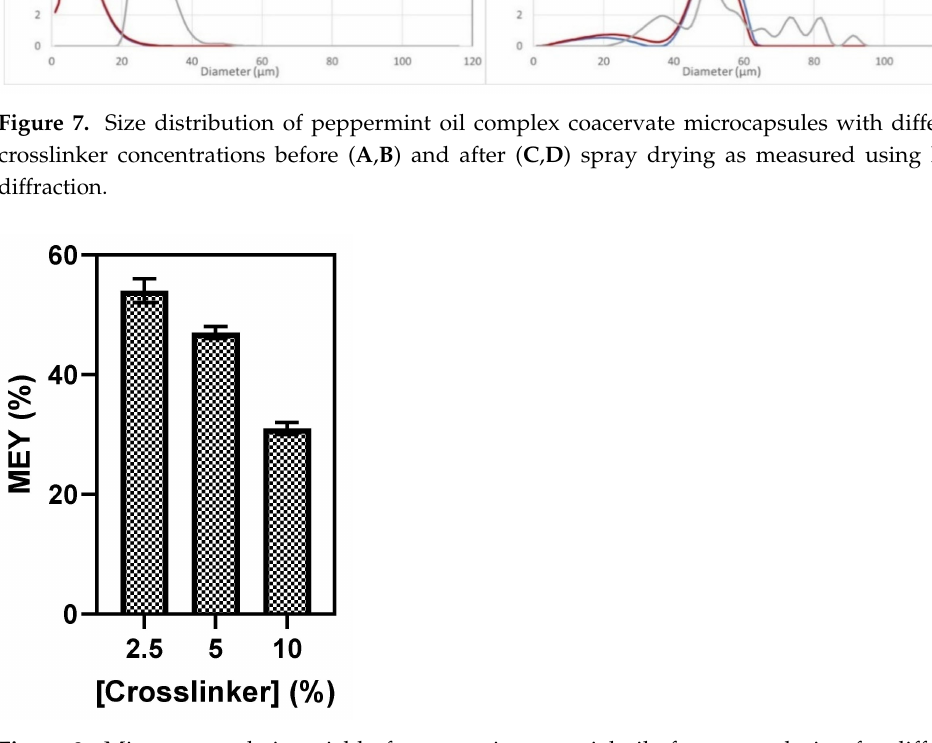
Figure 8. Microencapsulation yield of peppermint essential oil after spray drying for different crosslinker concentrations. Here, Polymer:Oil ratio was kept constant at 2:1 and total polymer concentration was 6